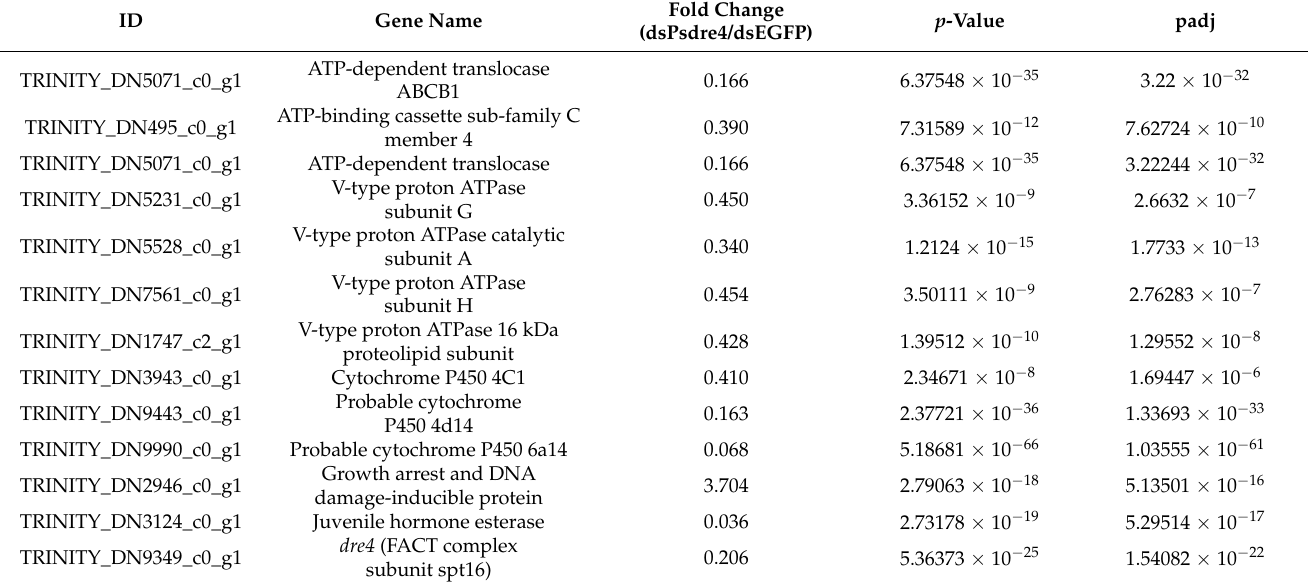
Table 2. Several significantly differently expressed genes associated with